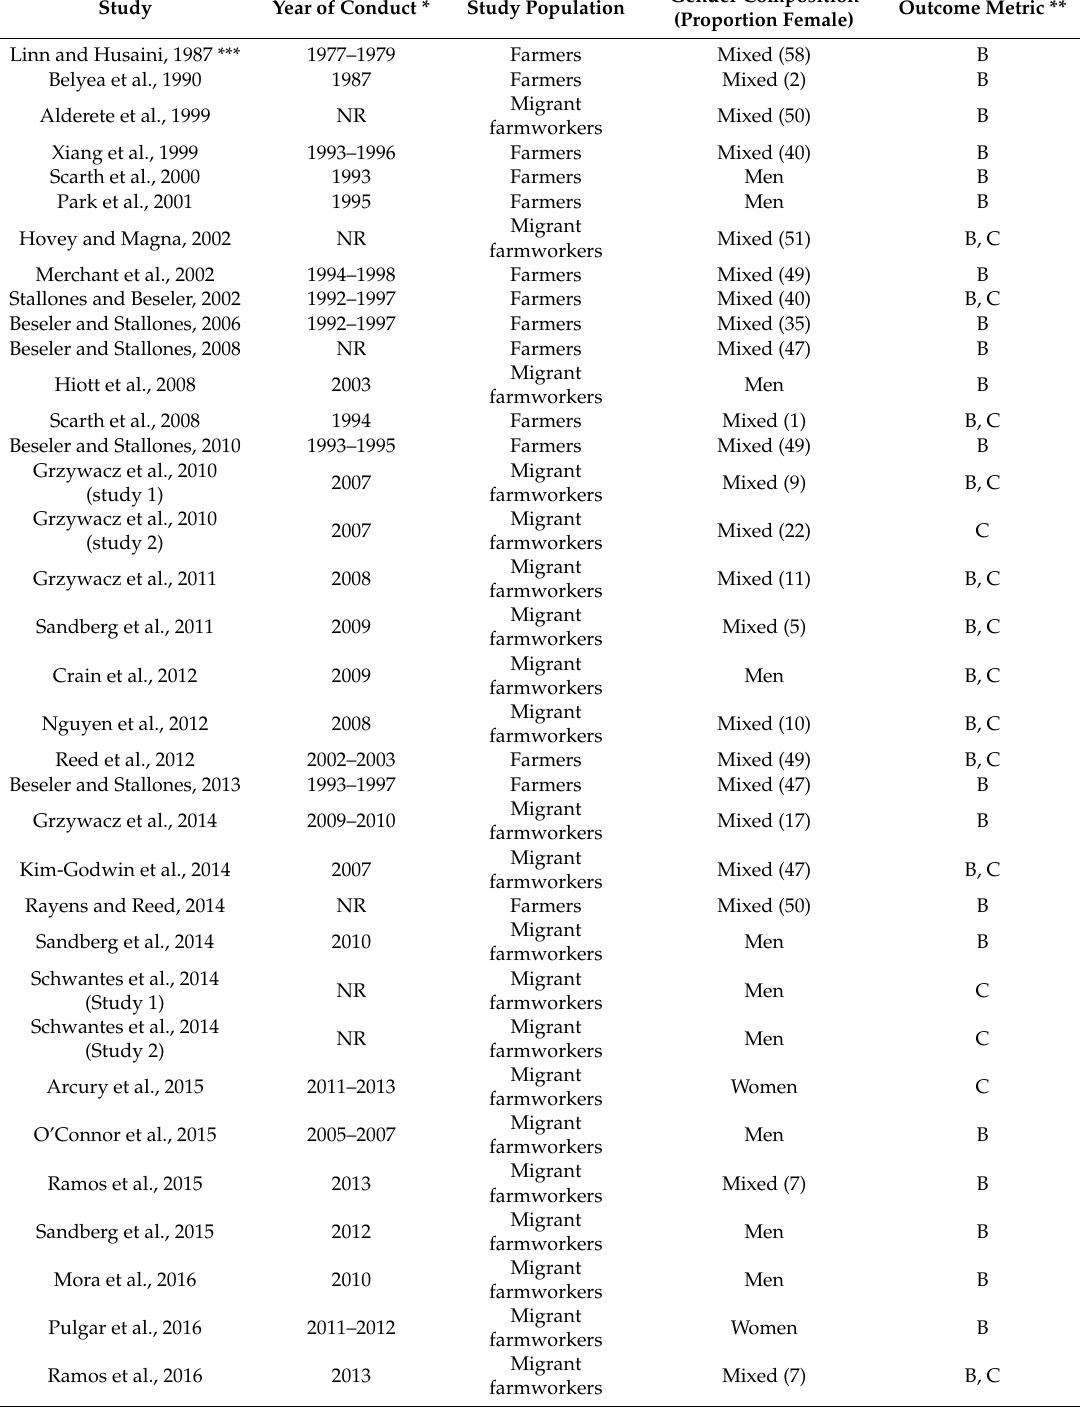
Table 1. Study characteristics for the 42 studies conducted in the United States using the CES-D / DR scale, included in the